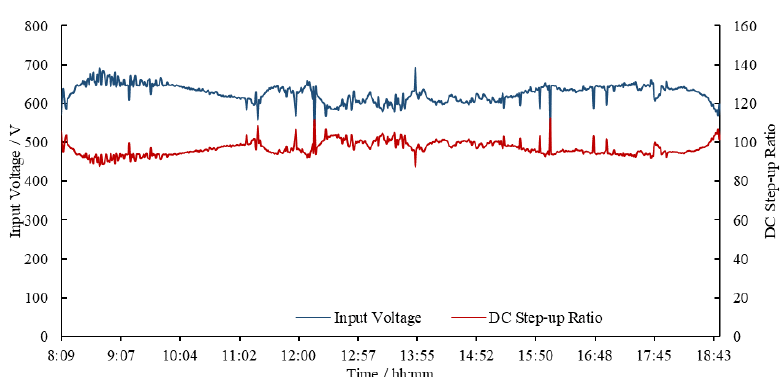
Figure 35. Input voltage and DC step-up ratio of the DC/DC converter on a cloudy day.